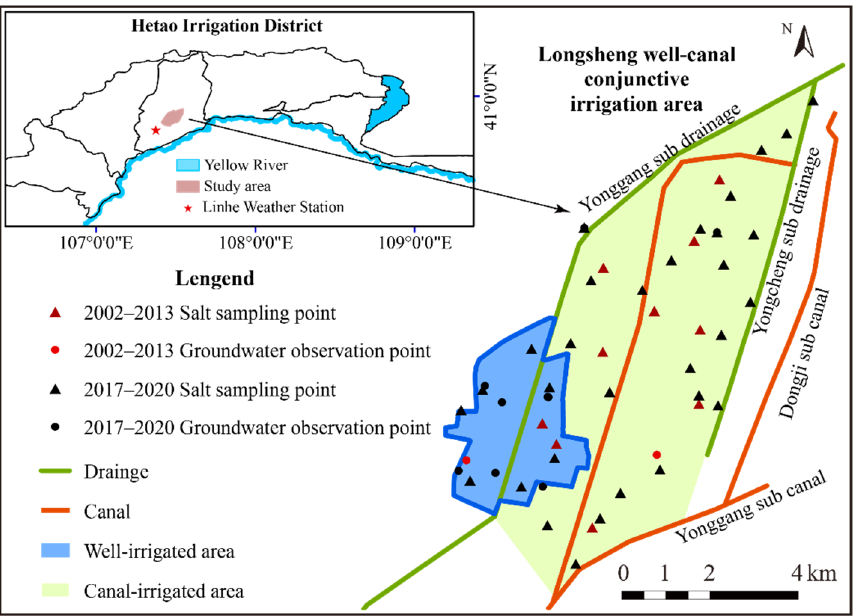
Figure 4. Geographic location and observation points of Hetao Irrigation District and the Longsheng well-canal conjunctive irrigation